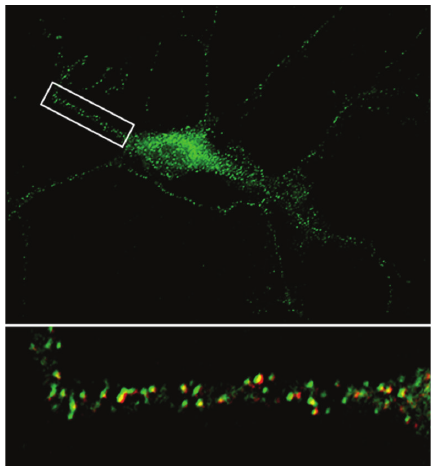
Figure 1: A pyramidal neuron expressing BDNF-eGFP. Insert shows BDNF-eGFP puncta in dendrites, which colocalize with the secretory granule marker SG2